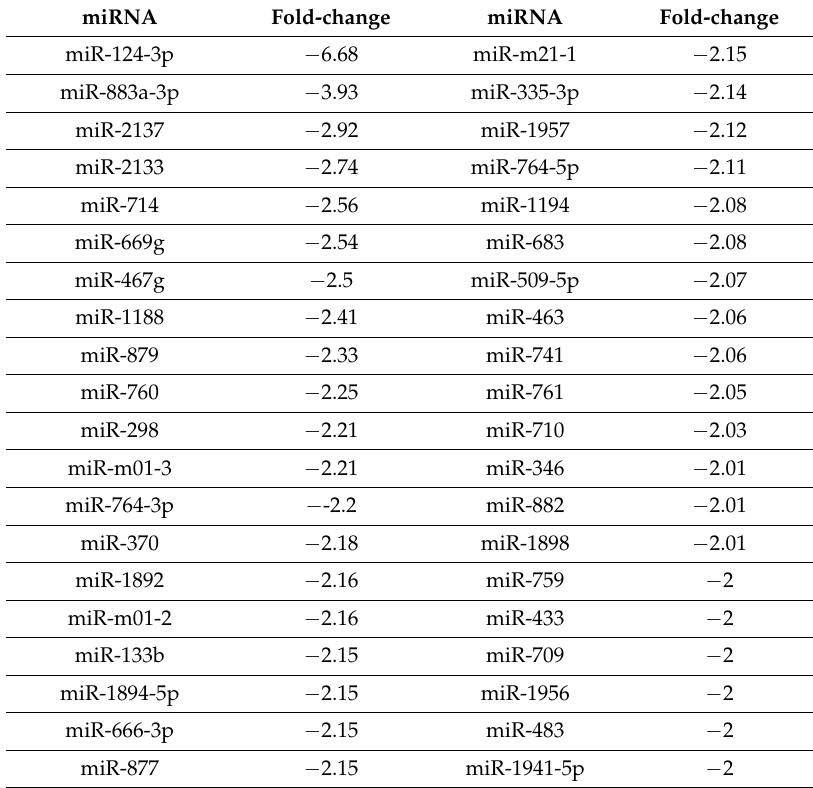
Table 4. Downregulated miRNAs at 48 h.